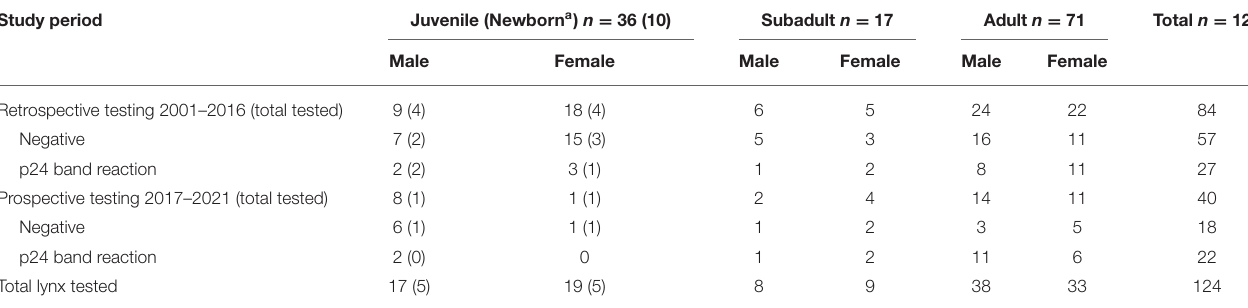
TABLE 1 | Wild-born Eurasian lynx ( Lynx lynx ) tested for exposure to feline immunodeficiency virus by Western blot at their first capture in Switzerland, 2001–2021. Study